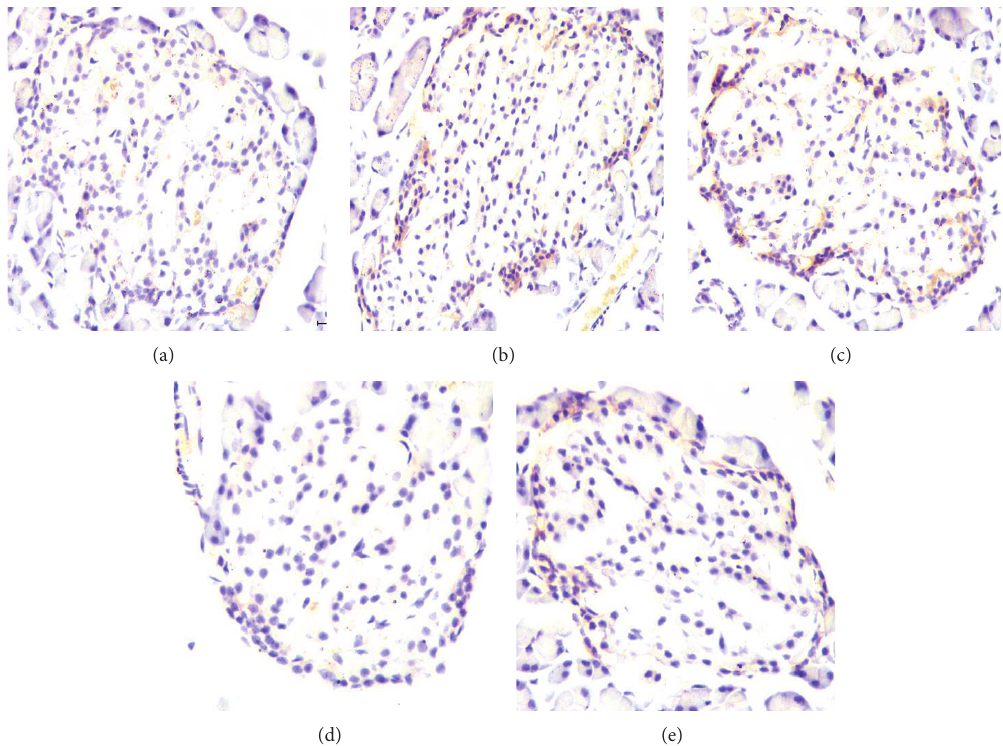
Figure 4: Cells staining positively for the PCNA marker in pancreatic islets ( × 400). Most PCNA-positive staining cells were distributed in the periphery of the islets and were in accordance with 𝛼 cells. (a) Con; (b) MSG; (c) MSG-HRP; (d) MSG-L; (e)